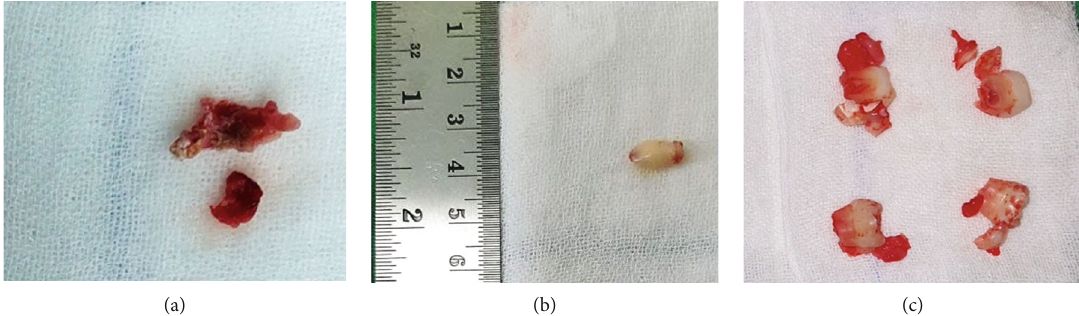
Figure 6: Specimen postoperative: (a) the cystic specimen after enucleation; (b) mesiodens; (c) tooth bud post